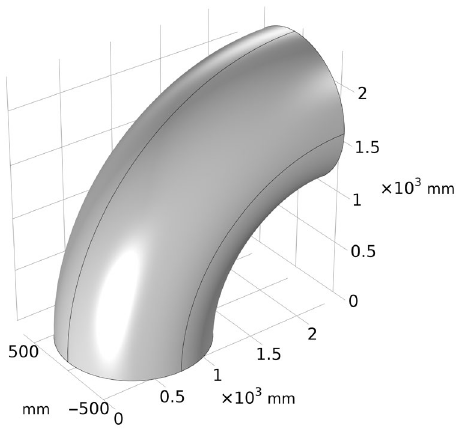
Figure 10. Calculation model of bending tube.